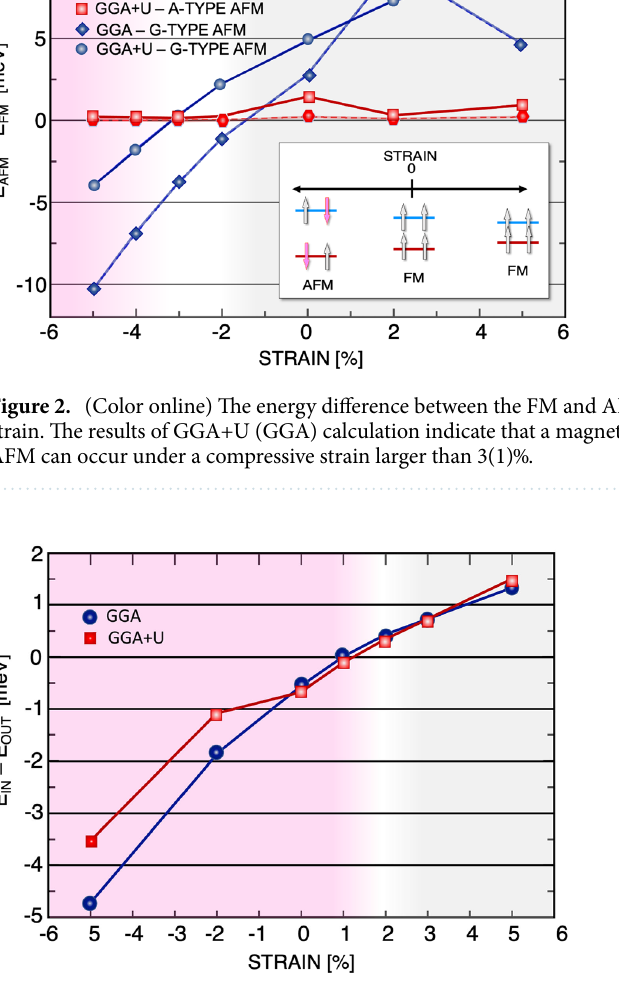
Figure 3. (Color online) Change in MAE of CrCl 3 bilayer with respect to the applied strain, within GGA and GGA+U approximations. A tensile strain equal to +2 % induces a phase transition to an out-of-plane easy axis in this bilayer.